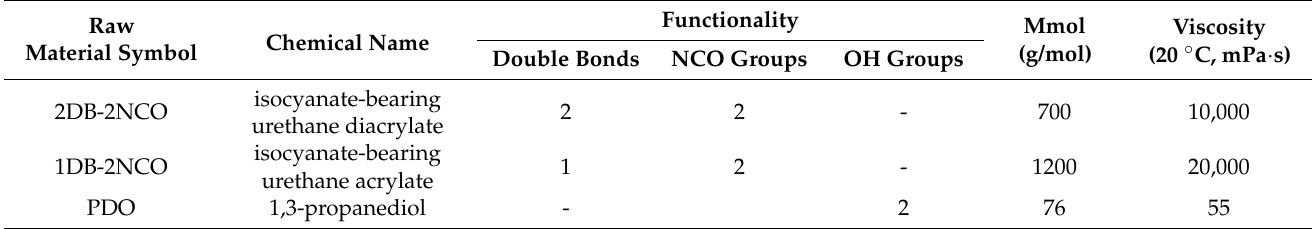
Table 1. Characteristics of the reagents used in the resin synthesis.